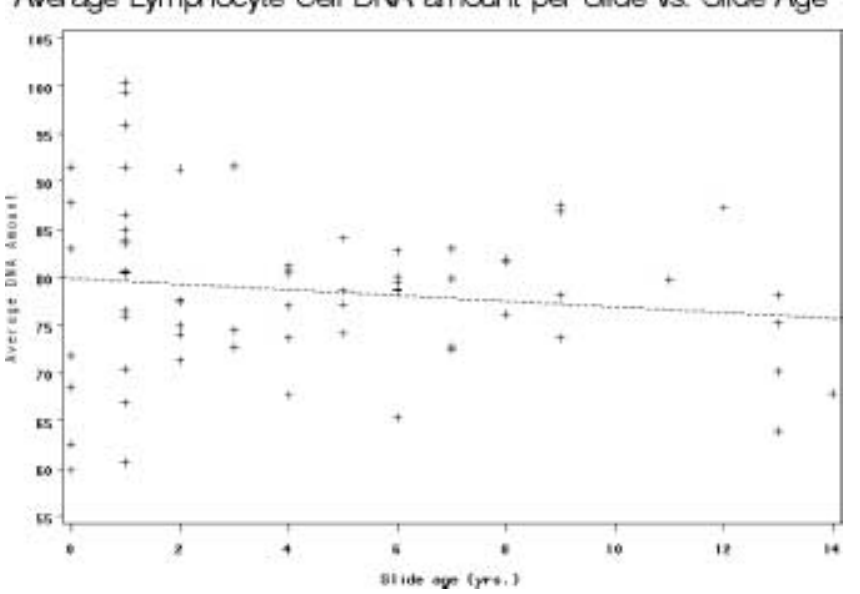
Fig. 3. This figure shows the plot of the average lymphocyte DNA amount for each of the tissue slices plotted against the age of the slide. The dotted line is the regression line. Again, the slope of the regression line was not statistically significant.